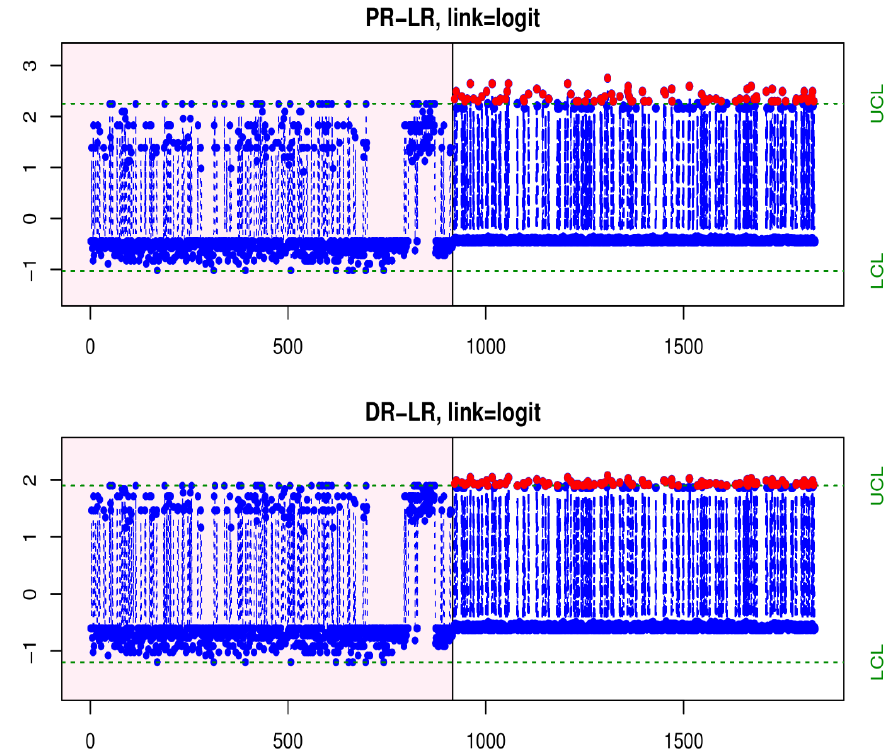
Figure 2. Control chart based on PR and DR with the logit link function.